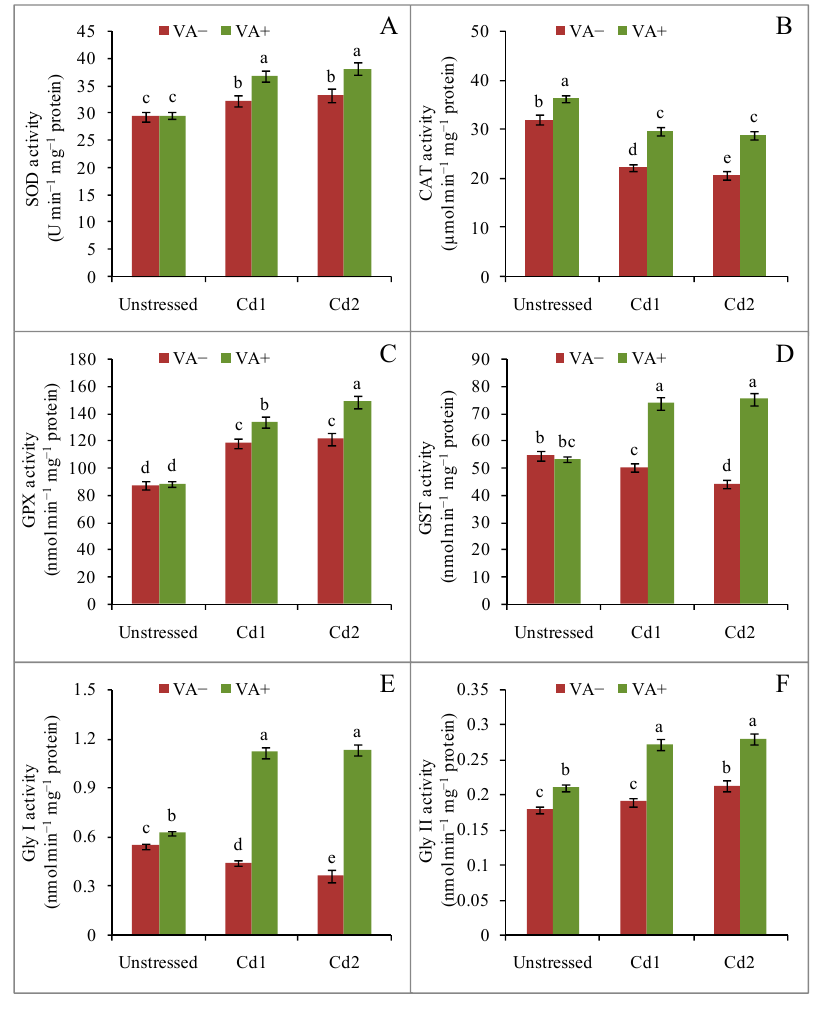
Figure 7. Effects of exogenous VA on activities of superoxide dismutase (SOD) ( A ), catalase (CAT) ( B ),glutathione peroxidase (GPX) ( C ),glutathione- S -transferase (GST) ( D ),glyoxalase I (Gly I) ( E ) and glyoxalase II (Gly II) ( F ) activity of rice ( Oryza sativa L. cv. BRRI dhan54) seedlings under Cd toxicity stress. Mean (± SD) was computed from three replications of each treatment. Bars with dissimilar letters are significantly different at p ≤ 0.05 from Fisher’s least significant difference (LSD) test .